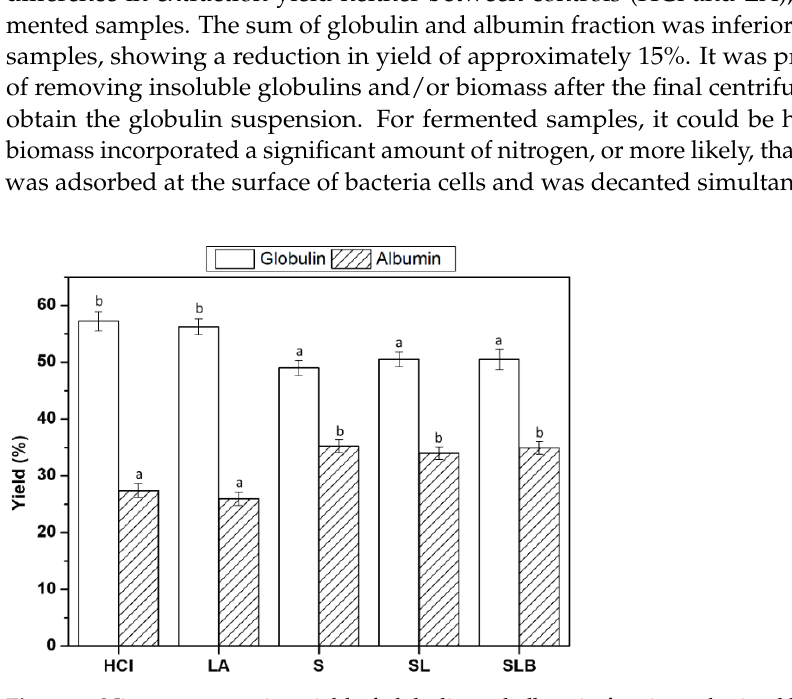
Figure 4. Nitrogen extraction yield of globulin and albumin fractions obtained by fermentations (S, SL, SLB) and controls (HCl, LA). Different letter represents significant differences among differ- ent samples (Turkey’s post hoc test).